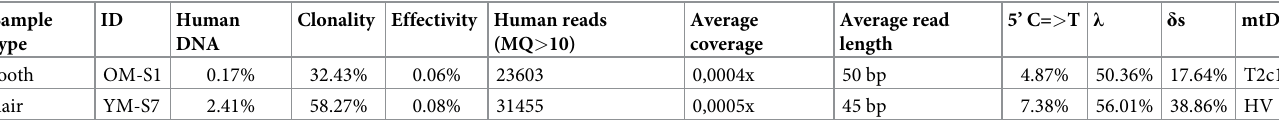
Table 3. Results of aDNA analysis from the two